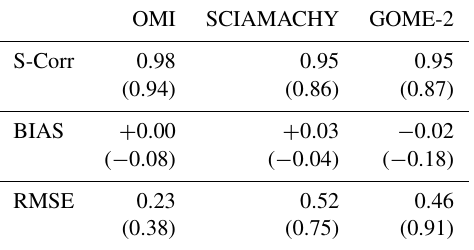
Table 1. Comparisons of tropospheric NO 2 columns between data assimilation and satellite retrievals: OMI for the period 2005– 2014, SCIAMACHY for the period 2005–2011, and GOME-2 for the period 2007–2014. Shown are the global spatial correla- tion (S-Corr), the mean bias (BIAS: the data assimilation minus the satellite retrievals) and the root-mean-square error (RMSE) in 10 15 moleccm − 2 . The model simulation results (without data as- similation) are also shown in brackets. OMI SCIAMACHY